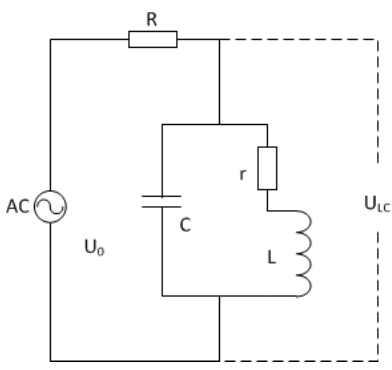
Figure 22. Resonant circuit used of eddy current measurements (adapted from [142]).